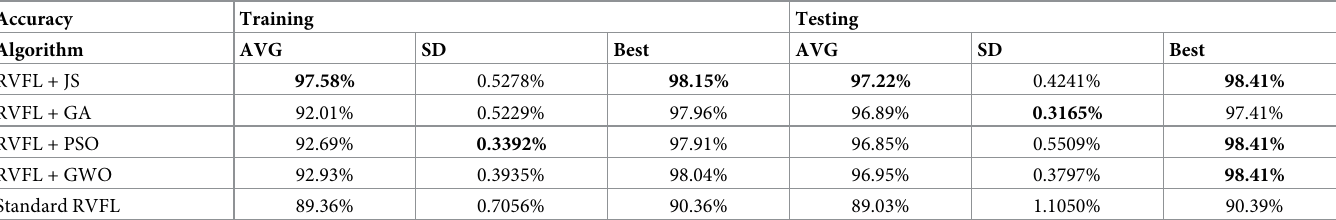
Table 6. Measurement accuracy of RVFL+ JS against other metaheuristic algorithms.